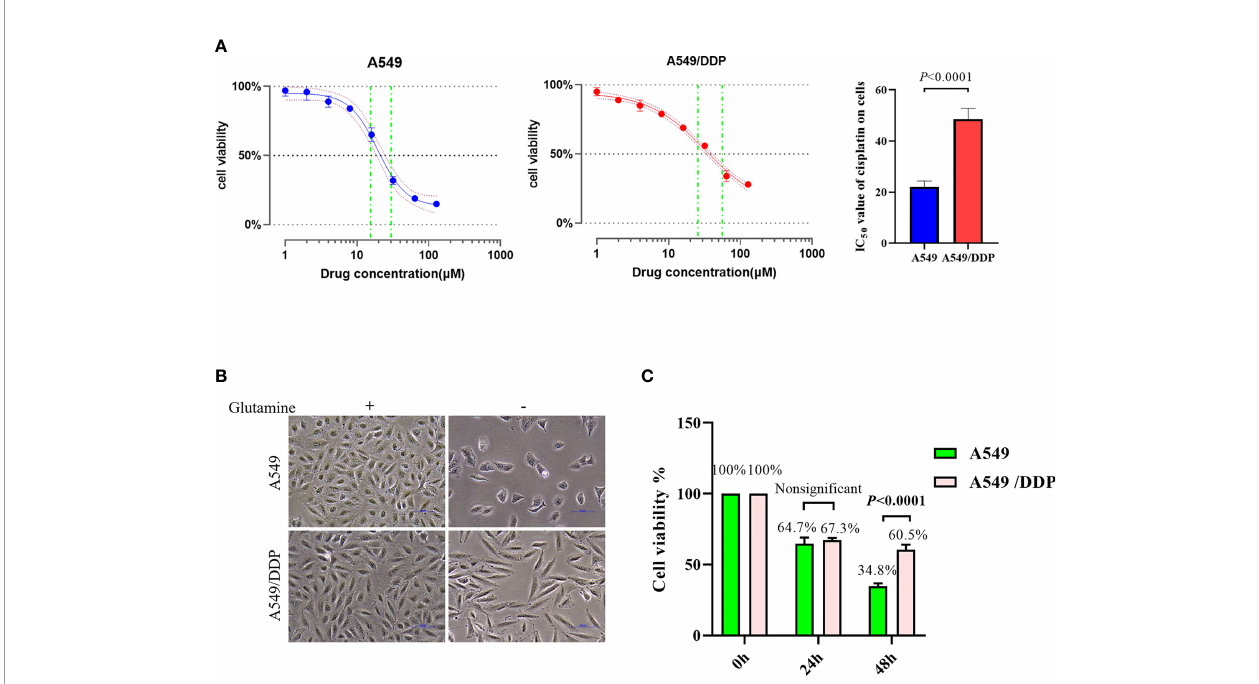
FIGURE 1 | A549/DDP cells attain phenotype resistance to cisplatin as well as acquire an adaptation mechanism during glutamine deprivation. (A) Inhibition rate of A549 and A549/DDP cells after 24 h of cisplatin treatment (0, 2, 4, 8, 16, 32, 64, and 128 m M), as well as IC 50 values of cisplatin in A549 and A549/DDP cells, are respectively represented by a line chart and a histogram. (B) Morphological observation of A549 and A549/DDP cells cultured with (+) or without ( − ) glutamine (2 mM; 48 h). (C) Cell viability assay 0, 24, and 48 h after glutamine deprivation in both cell lines. Experiments were repeated at least three times, and results were expressed as mean ±